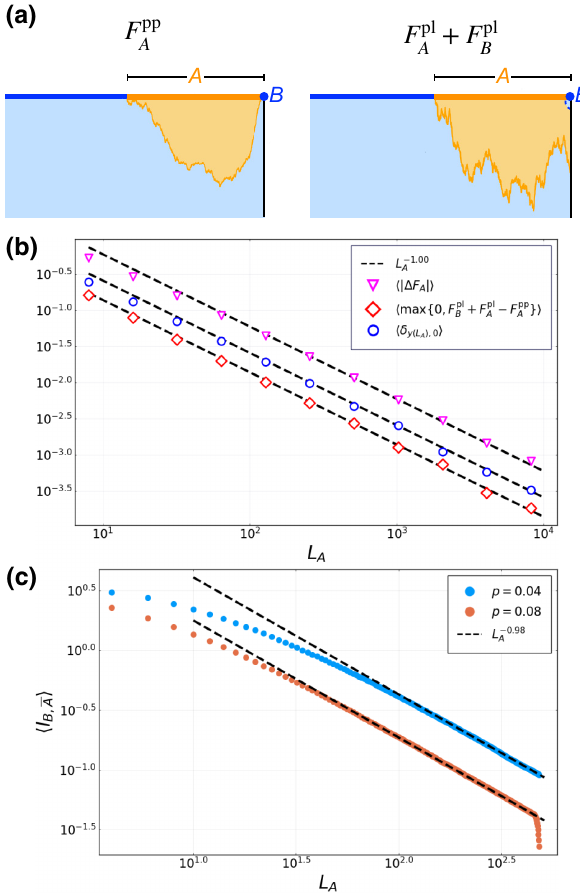
FIG. 7. (a) Two configurations of DPRE that contribute to S A − B in Eq. (28). The left plot is a point-to-point polymer that separates A − B from B ∪ A (as required by the assigned bound- ary conditions), and the right plot has two point-to-line polymers for the same boundary condition. (b) The mean values of several observables for the DPRE at zero temperature, which can all be (cid:7) for related to the DPRE mutual information [see Eq. (28)] (cid:6) I B , A the geometry in (a). This confirms Eq. (30). (c) The mean mutual (cid:7) computed from the random Clifford circuit for information (cid:6) I B , A the geometry in (a), with open spatial boundary condition. Here we take L B = 2, and L A ≤